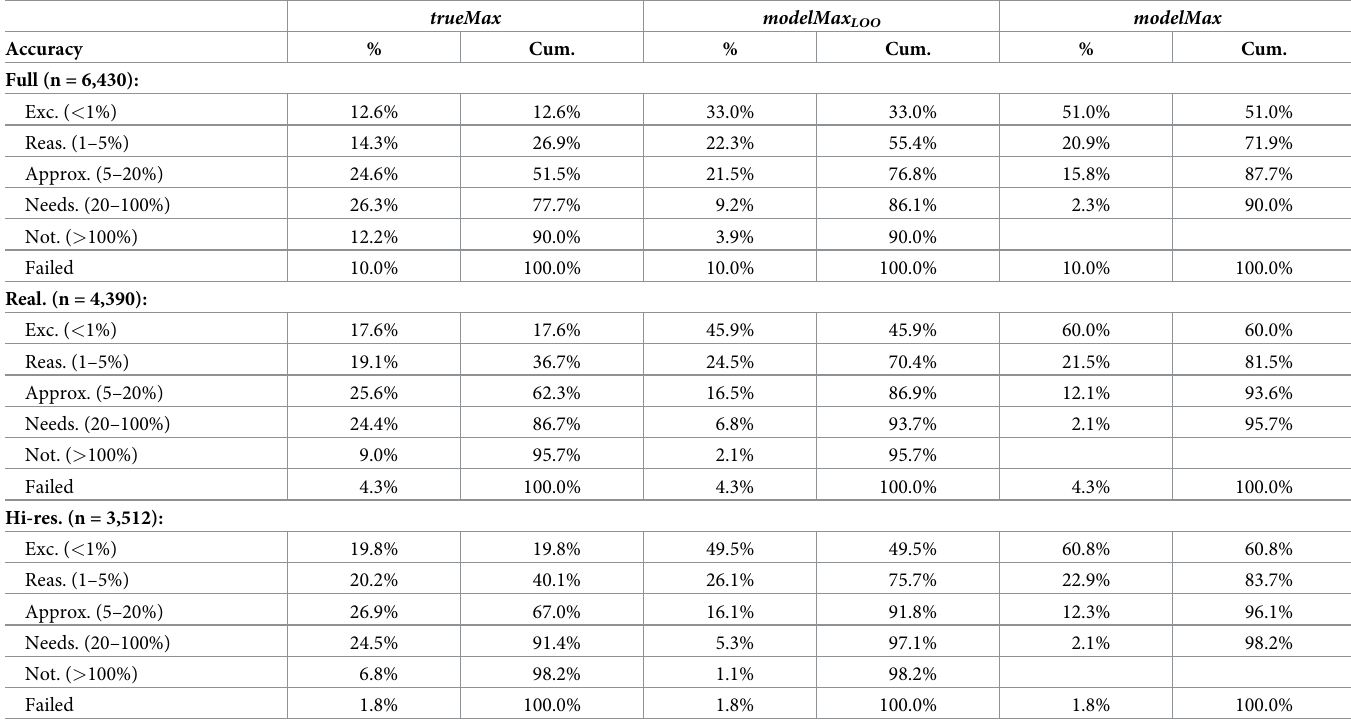
Table 2. Accuracy result metrics from the automated georeferencing of simulated maps. trueMax modelMax LOO modelMax Accuracy % Cum. Cum.